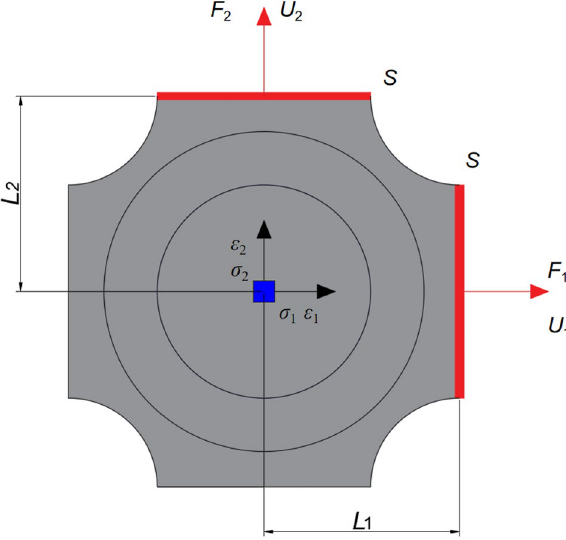
Figure 7. Schematic diagram of stress and strain calculation ( F i, U i, S are the force, displacement and area of the wall end of the specimen respectively; L i is the distance from the wall end to the center of the specimen; σ i and ε i are the stress and strain in the central area of the specimen